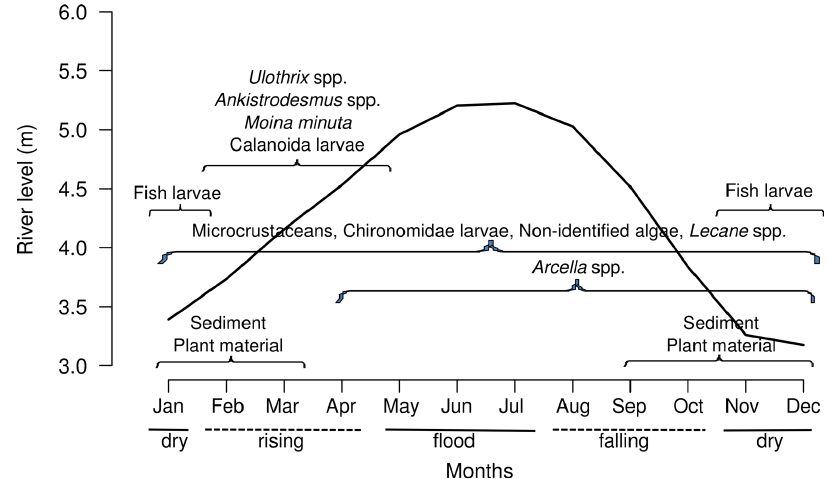
Figure 4. Temporal variation in River level and dietary composition of Odontostilbe pequira in the Paraguay and Amonguijá rivers, southern Pantanal at Porto Murtinho, MS,